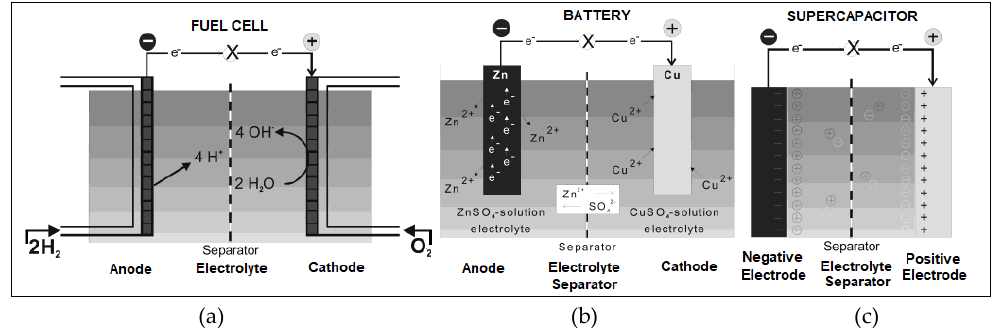
Figure 2. Representation of a fuel cell ( a ) shows the constant source of ingredients and redox reactions in the cell, a battery ( b ) shows the salient features of battery operation and a supercapacitor ( c ) illustrating the energy storage at probe-conducting solution interface. Reproduced with permission from [30].